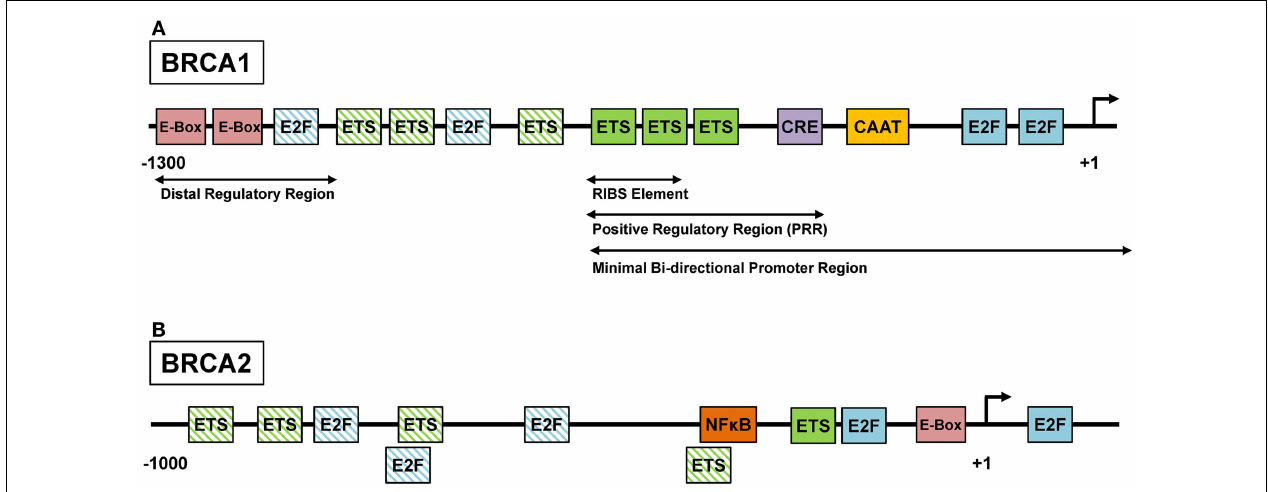
recognition motifs for transcription factors including E-box, E2F, and ETS (49). BRCA2 gene transcription may be activated by the binding of ELF1, an ETS factor, to the ETS recognition motifs or by the binding of USF1 and USF2, basic helix-loop-helix leucine zipper family members, to the E-box. Additionally, NF- κ B can also bind the BRCA2 promoter and induce genes expression (59). Functionally characterized binding sites are depicted by solid colored boxes. Putative binding sites are depicted by patterned boxes and were identified using the MatInspector software (Genomatix, Munich). Diagrams are not drawn to